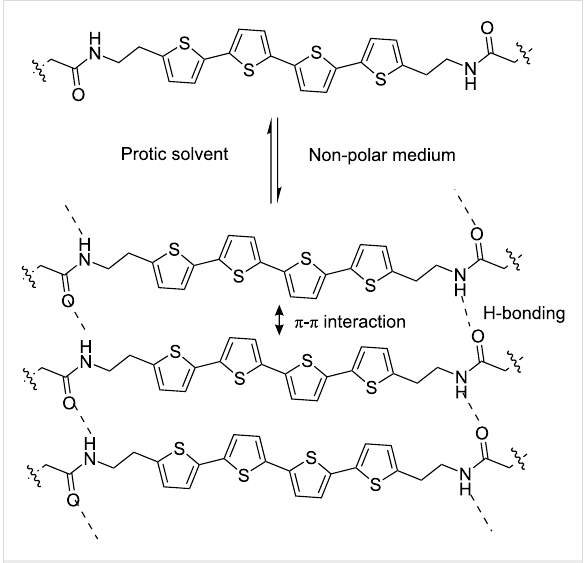
Scheme 3: Proposed mode of self-assembly of T1 .